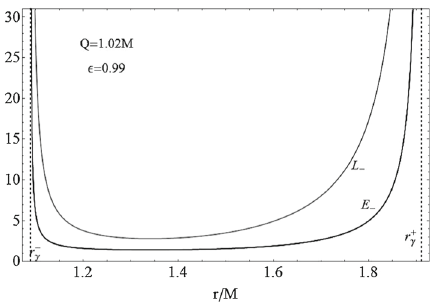
√ Fig. 12 Class : M < Q ≤ 5 /( 2 6 ) M and M / Q ≤ (cid:2) < 1. Parameter choice is as follows: Q = 1 . 02 M and (cid:2) = 0 . 99. Then (cid:9)(cid:9) (cid:2) + = 0 . 914942, r + s = 0 . 431596 M , r − γ = 1 . 08866 M , and r + γ = 1 . 91134 M . Circular orbits exist with angular momentum L = L + ( gray curve ) and energy E = E + ( black curve ) in r − γ < r < r + γ